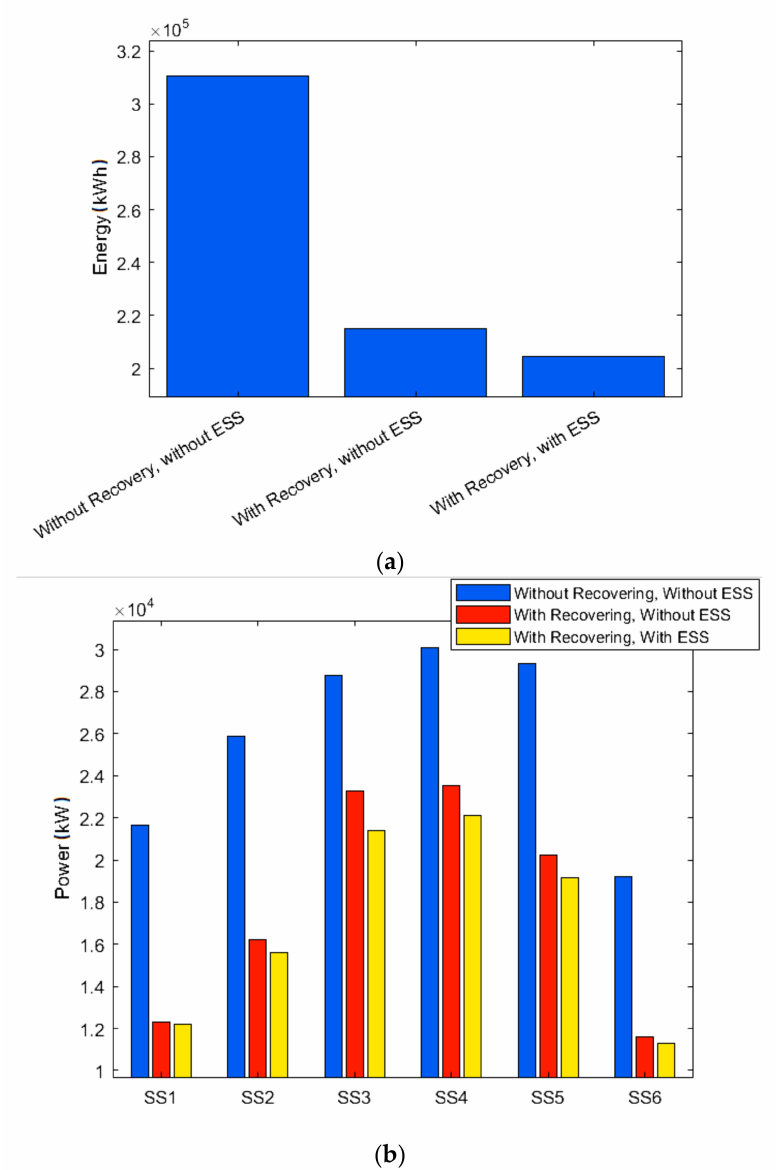
Figure 8. Graphic software output: ( a ) Total energy withdrawn from the primary network in a working day; ( b ) Power supplied by each substation present on the